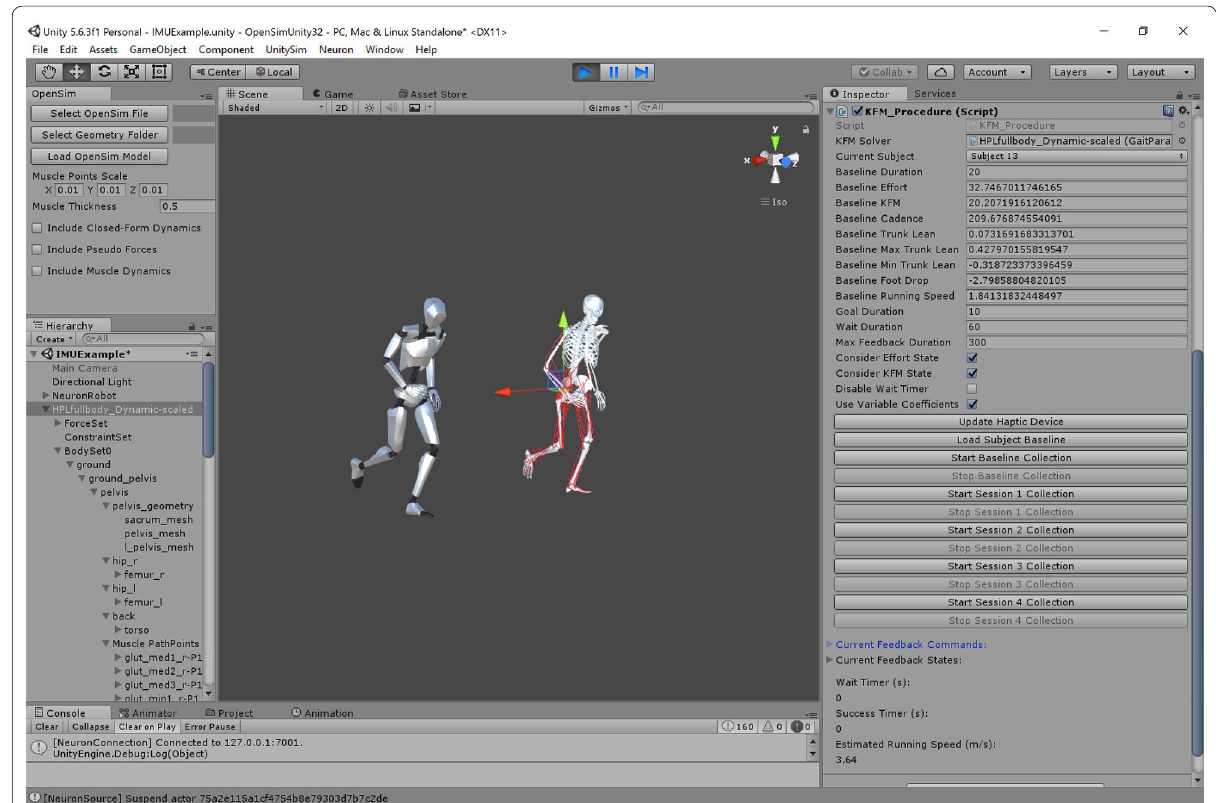
Fig. 3 Simulation framework: real-time motion reconstruction and subject’s baseline data acquisition